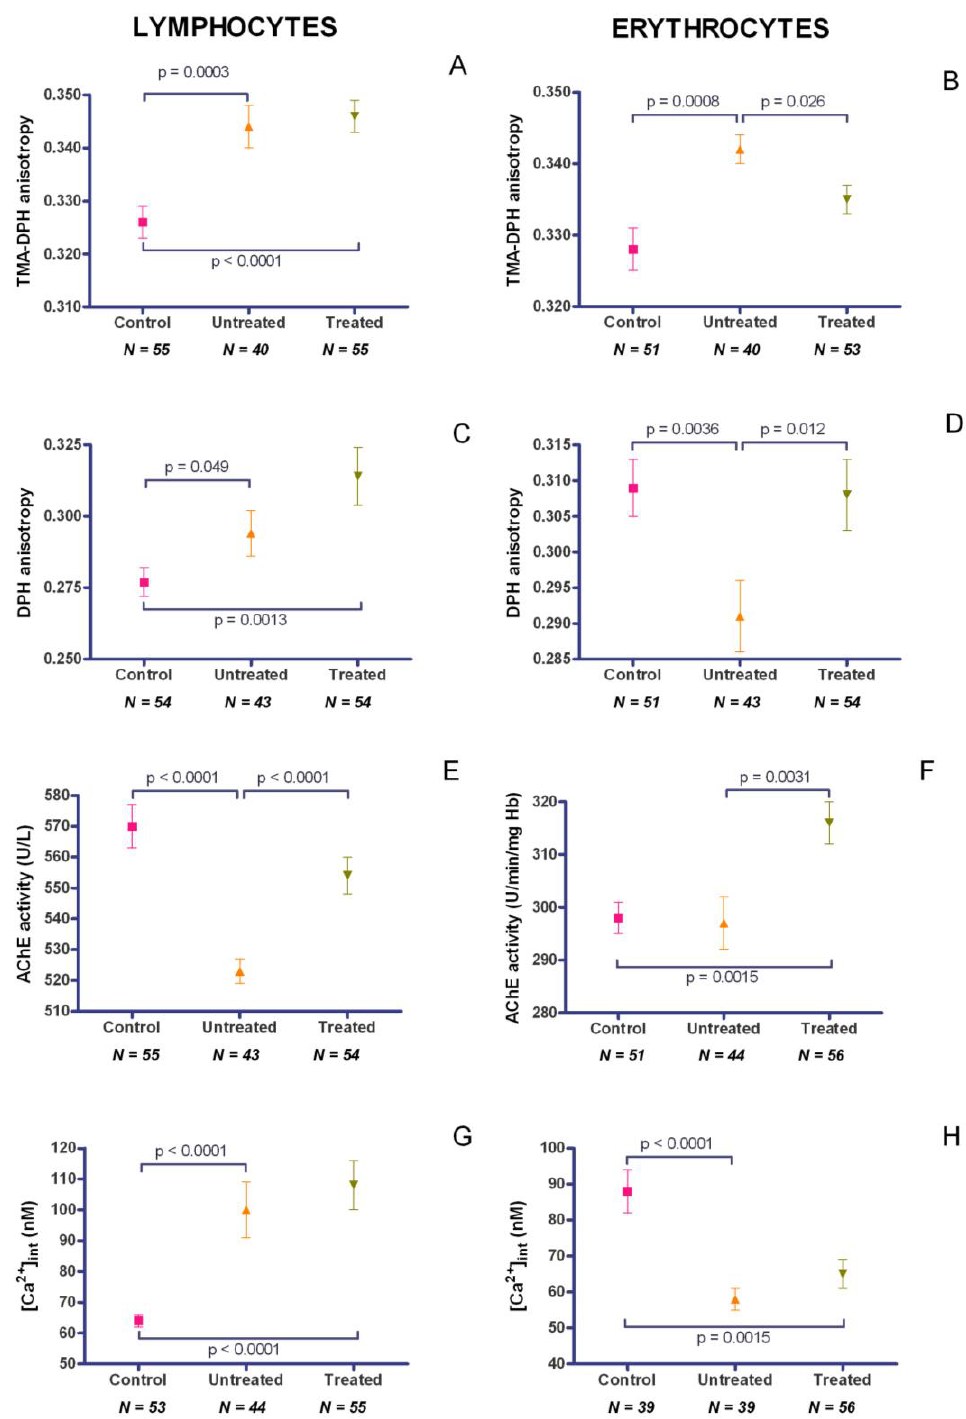
FIGURE 1. Values of TMA-DPH anisotropy (A and B), DPH anisotropy (C and D), AChE enzyme activity (E and F), and [Ca 2+ ] int (G and H) determined for the lymphocytes and erythrocytes obtained for the three studied groups: healthy subjects (control), antiretroviral treatment–naïve HIV-1–infected patients and antiretroviral-treated patients. Data are presented as mean  standard error. The p values obtained by the comparison of two groups using two-tailed unpaired samples t tests are presented whenever the variation is statistically significant ( p < 0.05). All the other pairings yielded nonsignificant